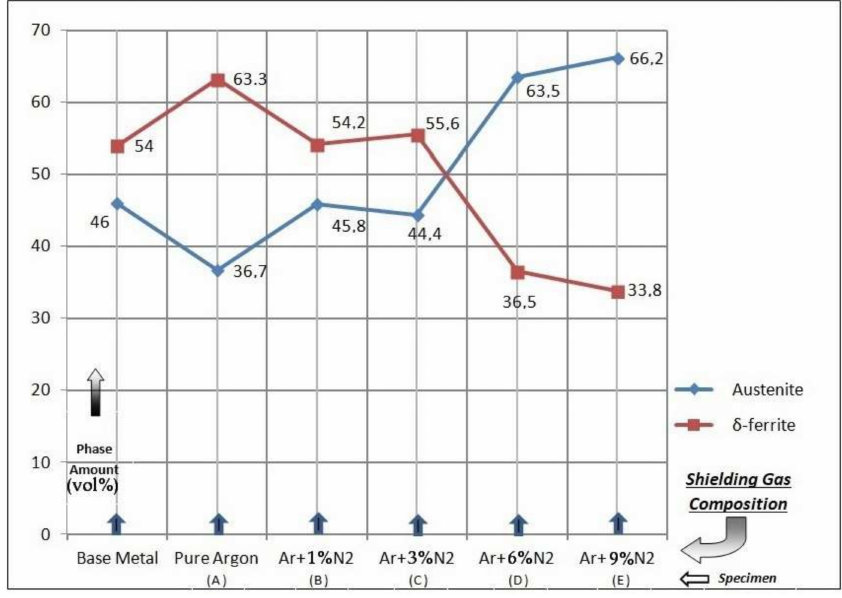
Figure 3. The effect of shielding gas composition on phase percentage